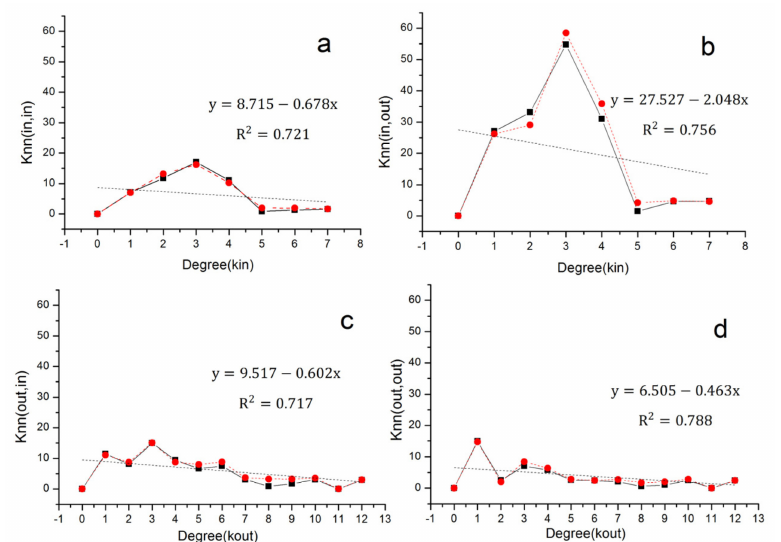
Figure 4. Correlation degree of virtual water trade network of China’s major crops. ( a ) Correlation degree of in-in node. ( b ) Correlation degree of in-out node. ( c ) Correlation degree of out-in node. ( d ) Correlation degree of out-out node. The solid line represents the correlation degree of the unweighted network, and the dotted line represents the weighted network correlation